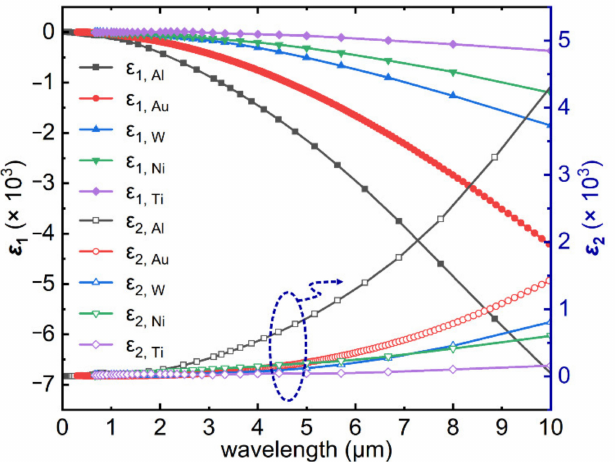
Figure A2. Real ( ε 1 ) and imaginary ( ε 2 ) parts of dielectric constants of various metals commonly used to construct nanophotonic devices in the deep-UV to mid-IR wavelength